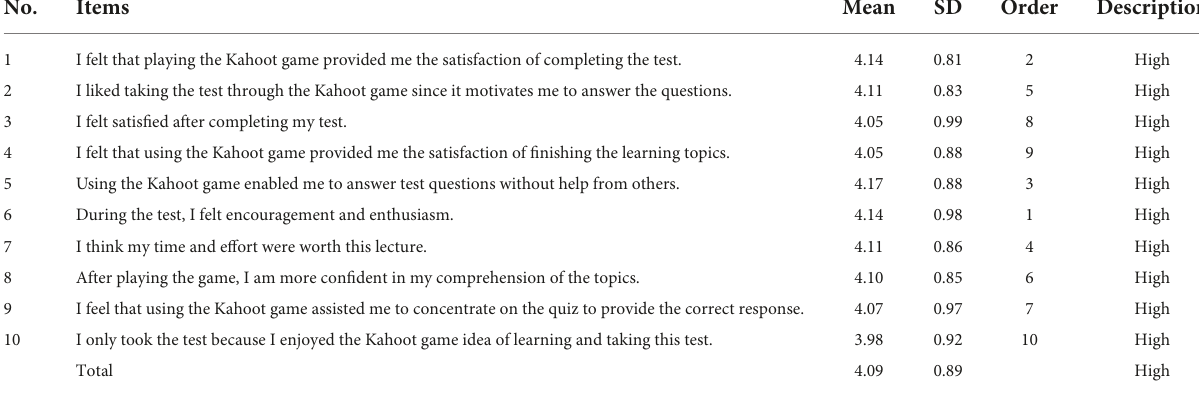
TABLE 4 Descriptive statistics of